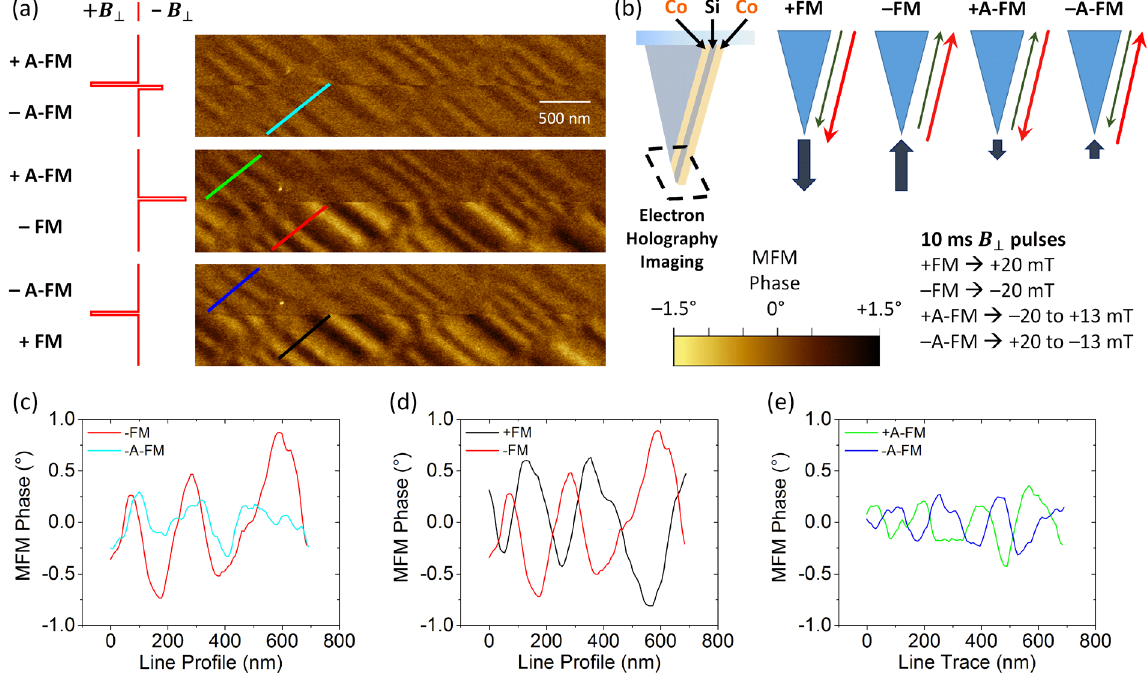
Figure 1. Switching of ML-MFM probes magnetic states. ( a ) MFM phase images of a reference floppy disk sample obtained with a thin ML-MFM probe in four different configurations ( ± FM and ± A-FM). Each of the three MFM phase images were obtained by continuously scanning from top to bottom, while applying pulses of the out-of-plane magnetic field ( B ⊥ , as represented by the red line schematics on the left) to switch the magnetic states of the probe. ( b ) Schematic representation of the four different ML-MFM probe configurations. Line profiles for ( c ) − FM and − A-FM, ( d ) + FM and − FM, and ( d ) + A-FM and − A-FM states, obtained along the lines of the corresponding colour in ( a